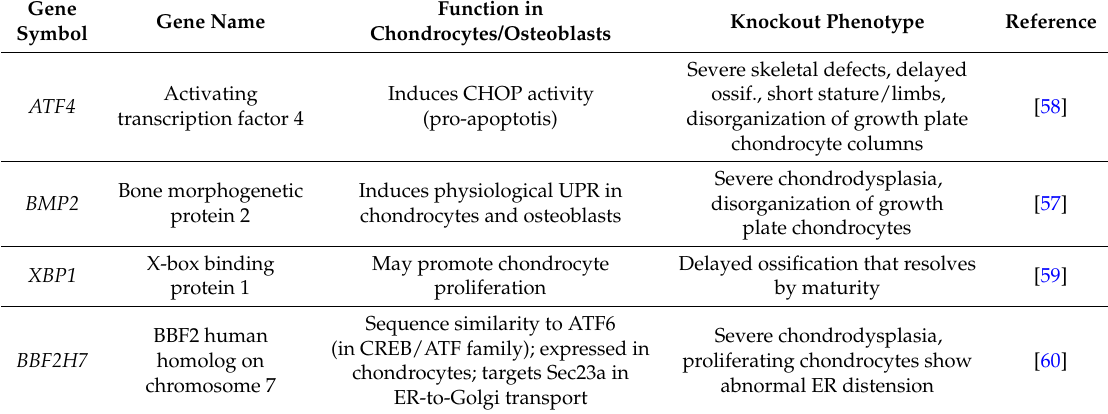
Table 2. Knockout of UPR-related genes that may result in a chondrodysplasia phenotype in